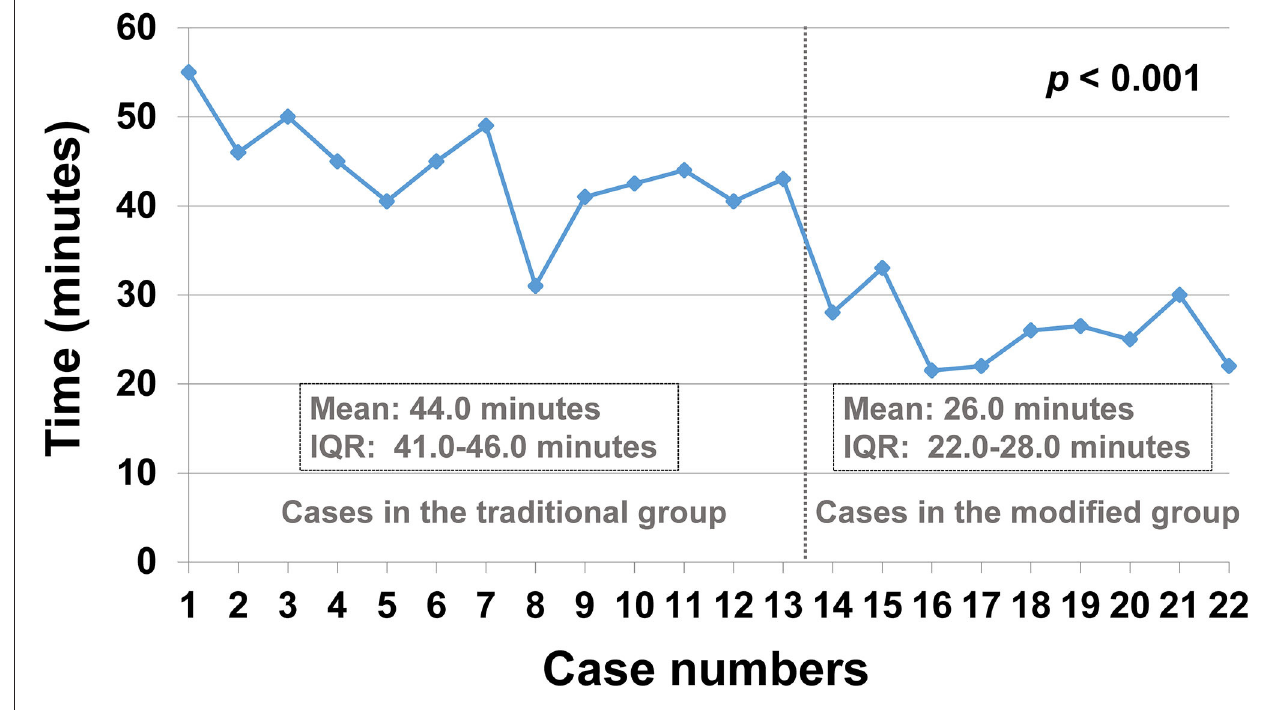
FIGURE 3 | The time used for pulling the ureter into the bladder for each case in chronological order. IQR, interquartile range.